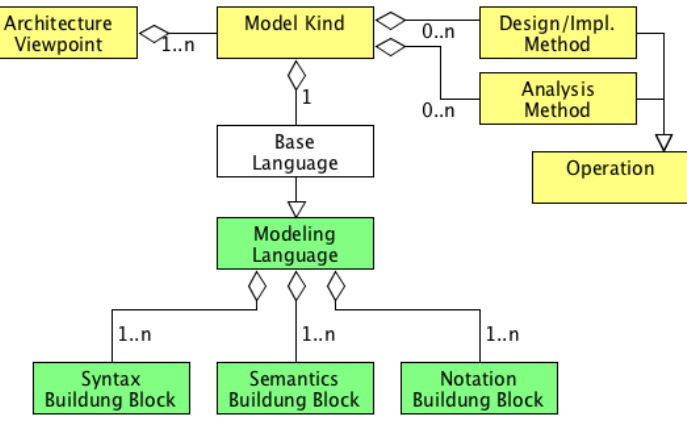
Figure 1. Detailing the Architecture Viewpoint [2] by integrating building blocks